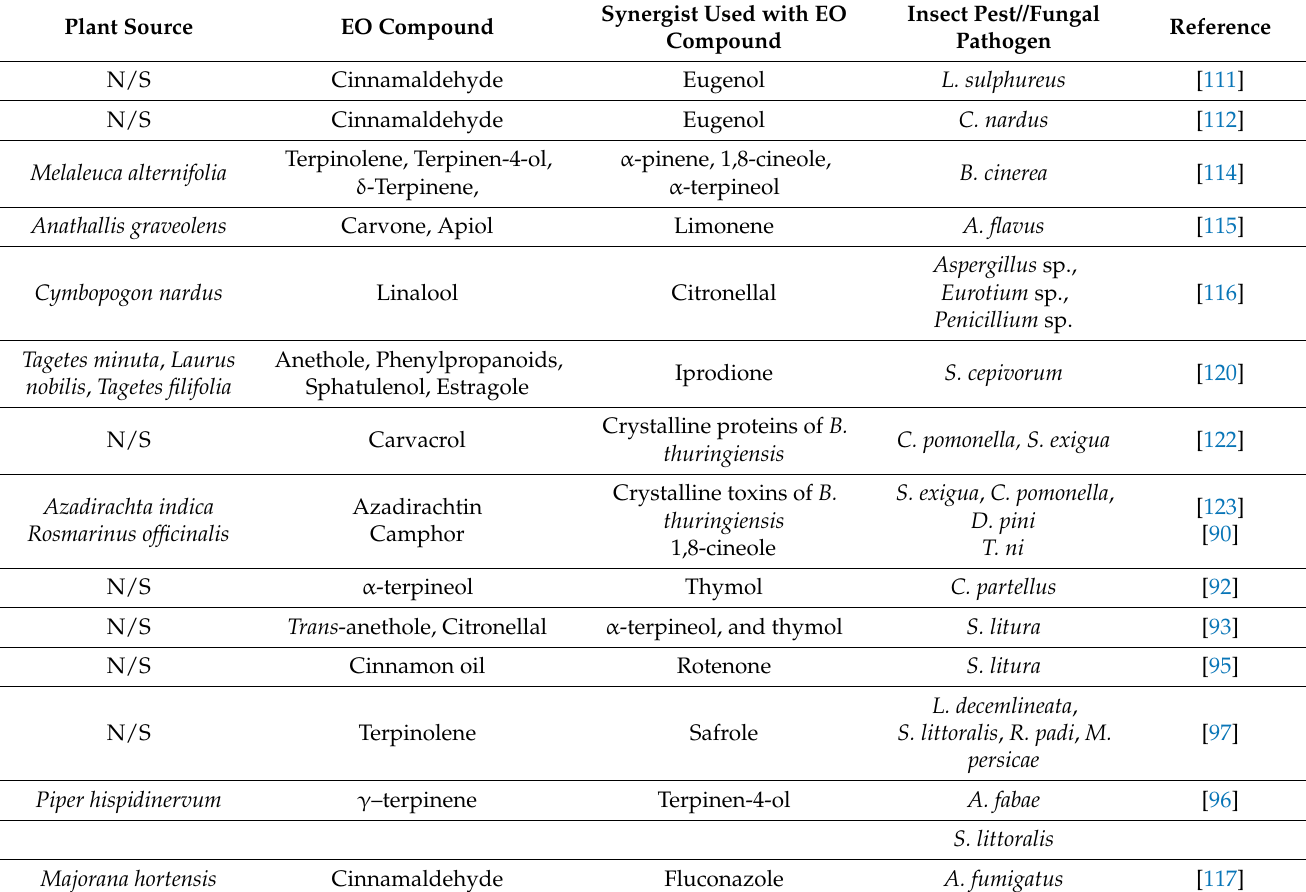
Table 1. Plant-derived essential oils and their compounds combined with synergistic agents against paddy field insect pests and fungal